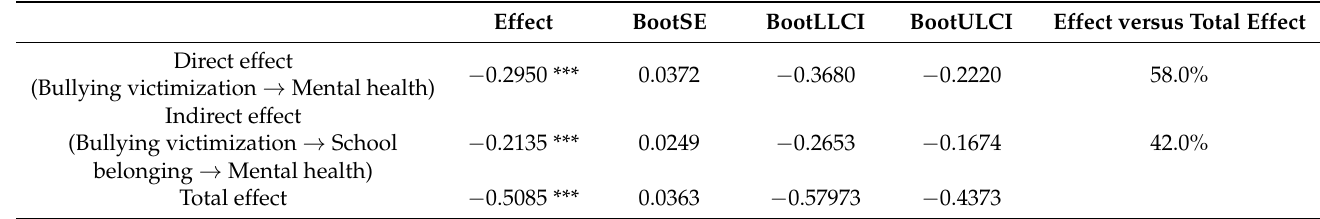
Table 5. Results of the mediation